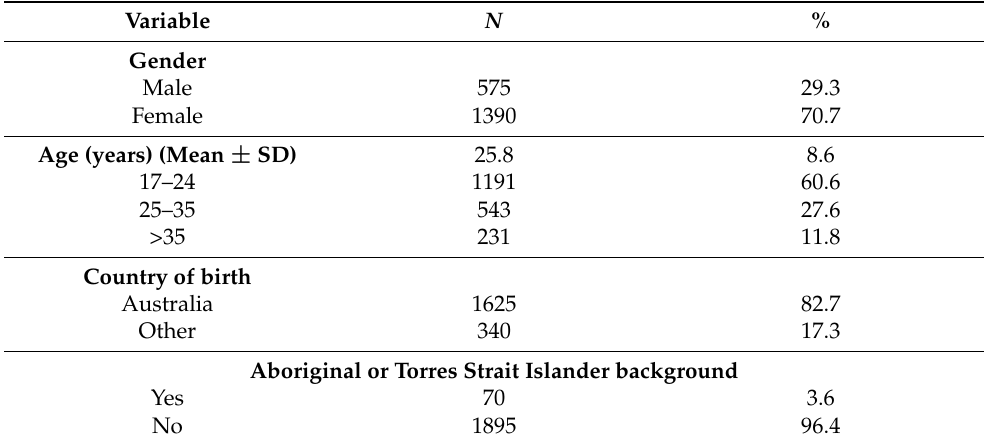
Figure 1. Flow of study participants. Table 1. Demographic, health behavior and psychological distress characteristics of a sample of Australian university students ( n =